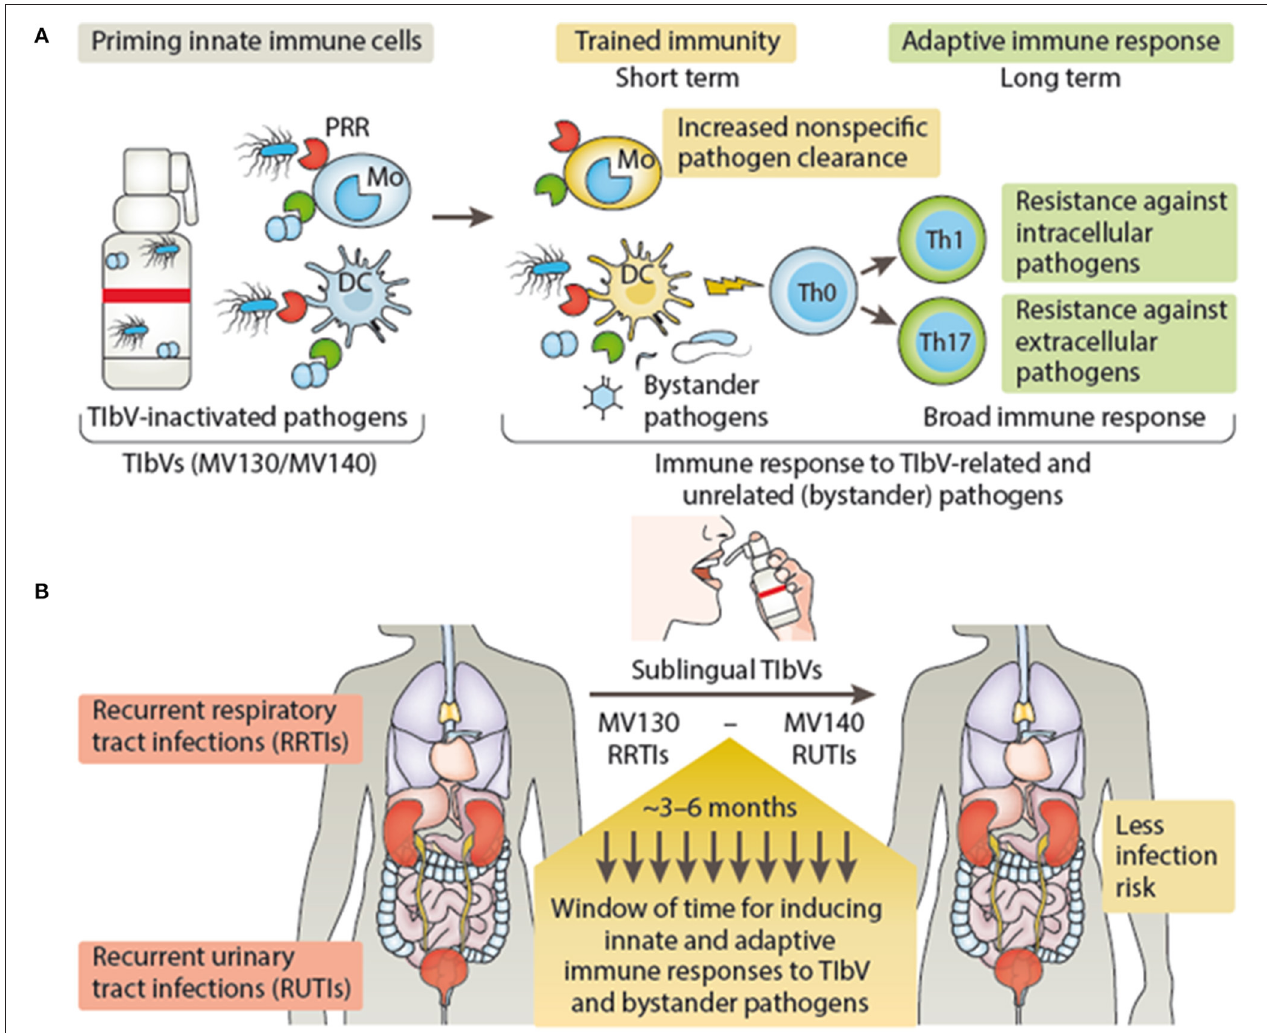
FIGURE 2 | Trained immunity-based vaccine mechanisms of action (A) and clinical outcome (B) . (A) TIbV act on the cells of the innate immune system, such as macrophages/monocytes and DCs inducing trained immunity which in turn will lead to nonspecific resistance and pathogen clearance. In addition, trained DCs enhance T cell responses and T helper differentiation (e.g., Th1 and Th17) against TIbV-related and unrelated (bystander pathogens) antigens. (B) In the context of recurrent respiratory or urinary tract infections, TIbV have the potential to induce a protective period of time providing the host resistance against TIbV-related and bystander pathogens during this frame time, reducing the infection rate. DC, dendritic cells; Mo, monocyte; PRR, pattern recognition receptor; Th, T helper cell; Th0, naïve T cells; TIbV, trained immunity-based vaccine. MV130, polybacterial vaccine containing whole cell heat-inactivated bacteria that produce frequent infections in the respiratory tract. MV140, polybacterial vaccine containing whole cell heat-inactivated bacteria that produce frequent infections in the urinary tract.